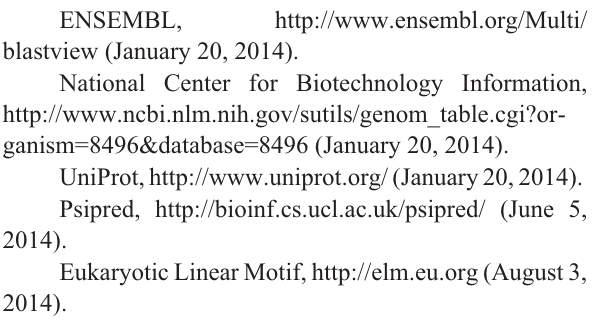
Table S1 – Species included in the analyses. Table S2 – Estimated parameters under different codon substitution models. Table S3 – Amino acid changes at AVPR1b positions and relaxed functional constraints. Table S4 – Disorder content within OXTR